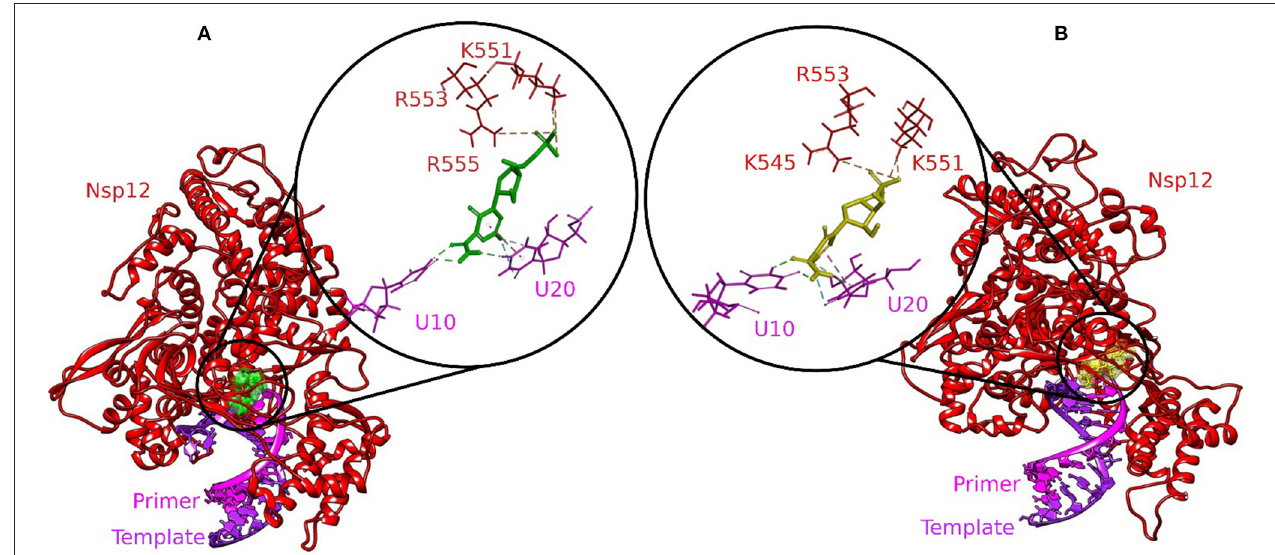
FIGURE 1 | Molecular docking interaction poses of (A) Remdesivir and (B) Favipiravir with the active site of the RNA–RdRp complex of SARS-CoV-2. The color-coding scheme is as follows: H-bonds (green), pi-alkyl/alkyl (pink), pi-sulfur (golden yellow), and pi-lone pair